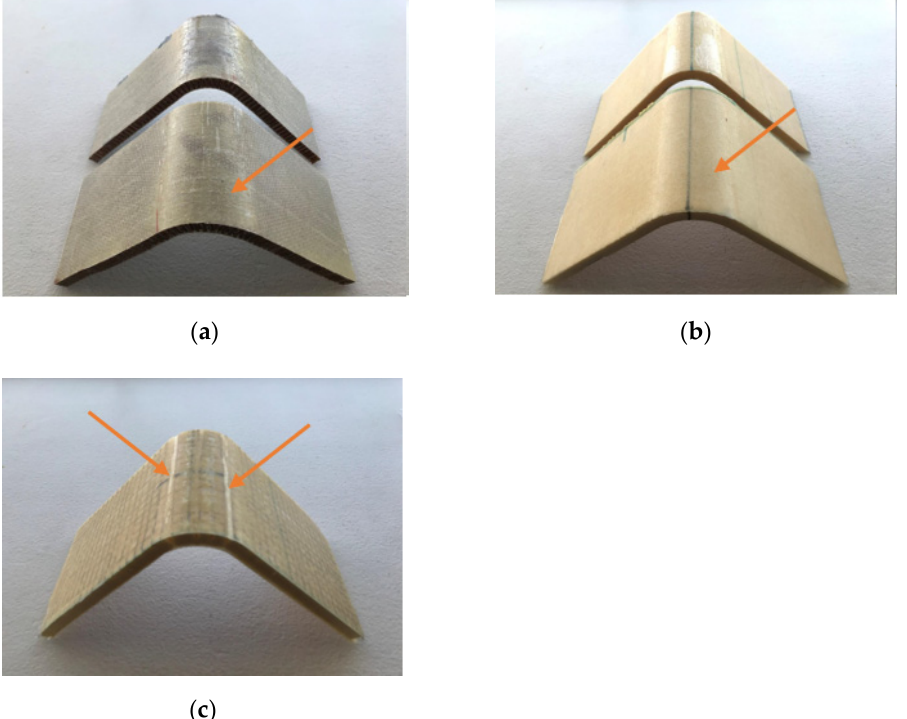
Figure 6. Pictures corresponding to the V ‐ shaped panels of: ( a ) GF/HC/GF, ( b ) GF/Foam/GF, and ( c ) GF/griding foam/GF. ( c ) GF/griding